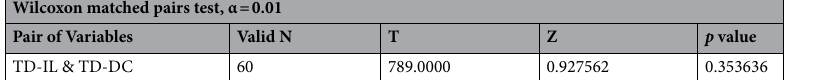
Wilcoxon matched pairs test, α =